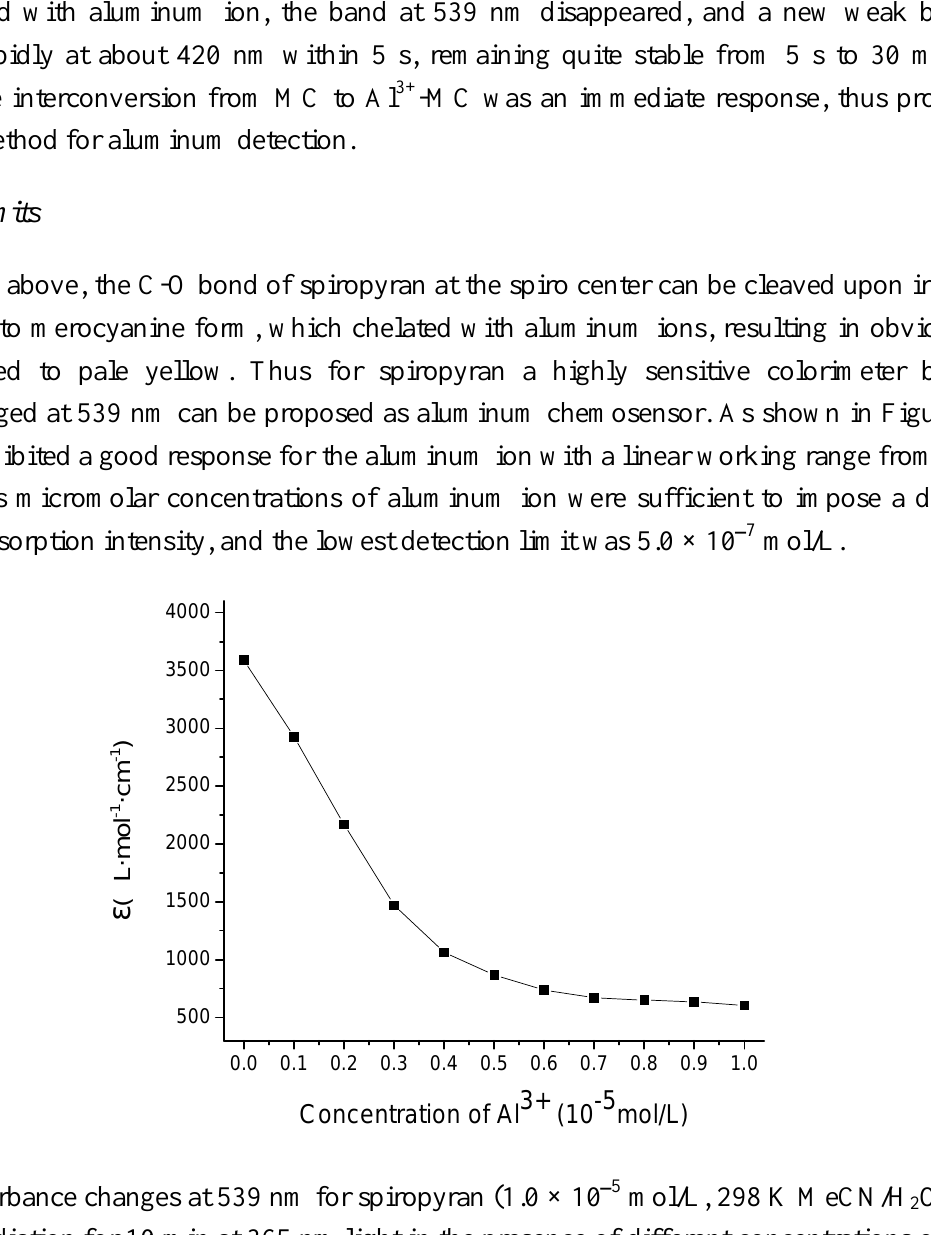
Figure 5. Absorbance changes at 539 nm for spiropyran (1.0 × 10  5 mol/L, 298 K MeCN/H V/V) with irradiation for 10 min at 365 nm light in the presence of different concentrations of Al 3+